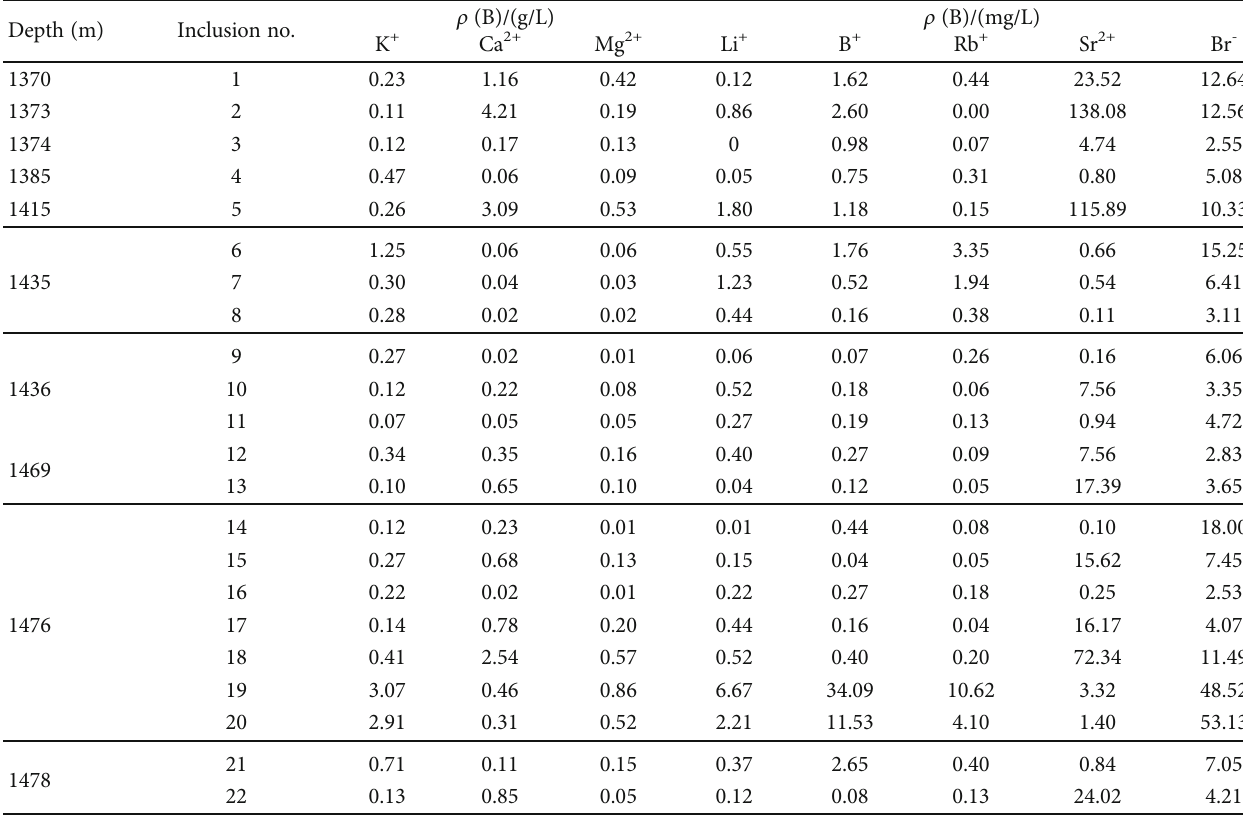
Table 2: Ion concentrations in halite fl uid inclusions from borehole DZK01 in the Kuqa Basin. Depth (m) Inclusion no.